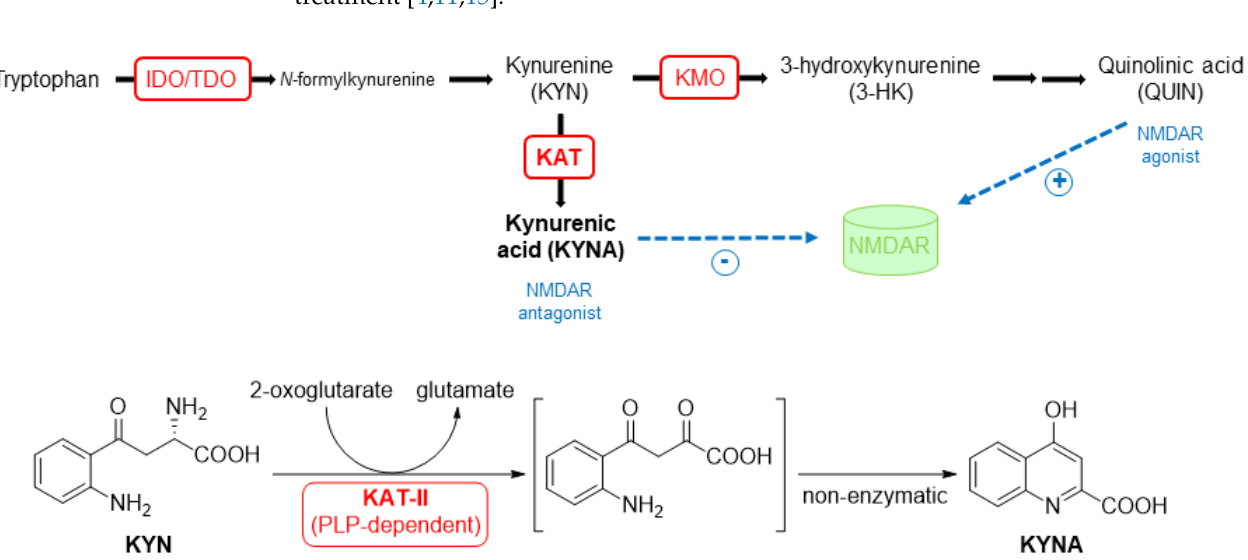
Figure 1. Schematic representation of the kynurenine pathway and the detailed description of KAT-II catalyzed transformation of kynurenine to kynurenic acid. IDO = indolamine-2,3-dioxygenase, TDO = tryptophan-2,3-dioxygenase, KMO = kynurenine-3-monooxygenase, KAT = kynurenine aminotransferase, NMDAR = N -methyl- D -aspartate receptor, KYN = kynurenine, KYNA = kynurenic acid, 3-HK = 3-hydroxykynurenine, QUIN = quinolinic acid, PLP = pyridoxal- 5′ -phosphate.